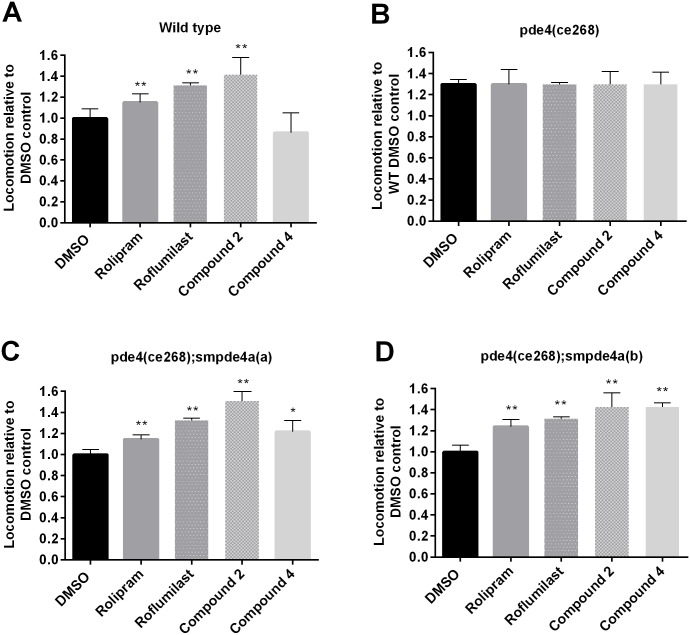
PDE4 inhibitors induce hypermotility in transgenic C. elegans expressing smpde4a.C. elegans was exposed to 100 μM rolipram, roflumilast or the benzoxaborole compounds 2 and 4, and then worm motility measured. Effects on (A) WT, (B) hypermotile mutant pde4(ce268), (C) transgenic pde4(ce268);smpde4a(a) and (D) transgenic pde4(ce268);smpde4a(b) are shown. Means and standard deviations for motility are normalized over two experiments to DMSO controls; each experiment involved measuring at least 10 worms per treatment. The asterisks in each panel indicate significance by Student’s t-test (*p<0.005; **p<0.0005) relative to the respective DMSO controls. For Panel B, motility was normalized to that recorded for the WT control.